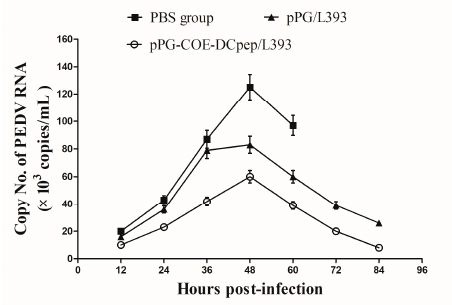
Figure 5. Real-time reverse transcriptase polymerase chain reaction (RT-PCR) of clinical samples. PEDV shedding in the pPG-COE-DCpep/L393 , pPG/L393 , and PBS groups, was collected every 12 h.